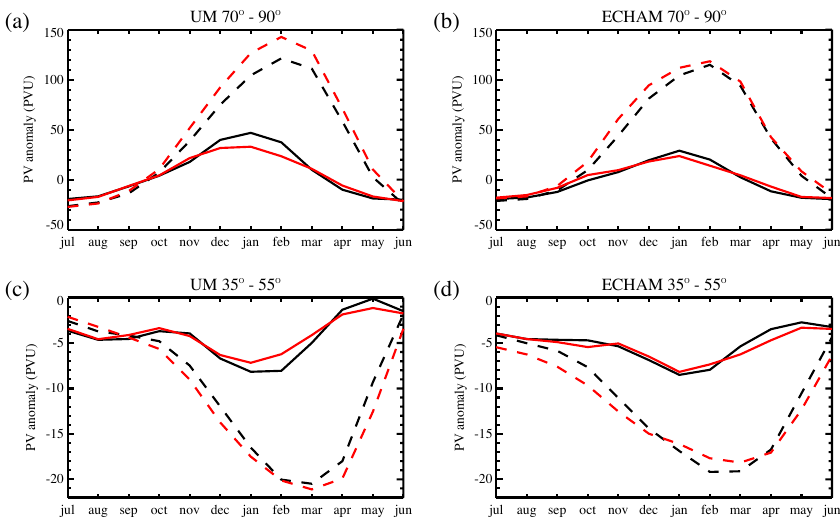
Fig. 2. Monthly climatological 600K polarcap PV anomaly (PVU) for (a) the UM model and (b) the ECHAM model, and 600K midlatitude PV anomaly (area-weighted average between 35 ◦ and 55 ◦ , in PVU) for (c) the UM model and (d) the ECHAM model, for the control run (black lines) and the doubled CO 2 run (red lines) for the NH (solid) and minus the SH (dashed). Months noted on the horizontal axis are for the NH, and the SH values are shifted by 6 months compared to this axis.